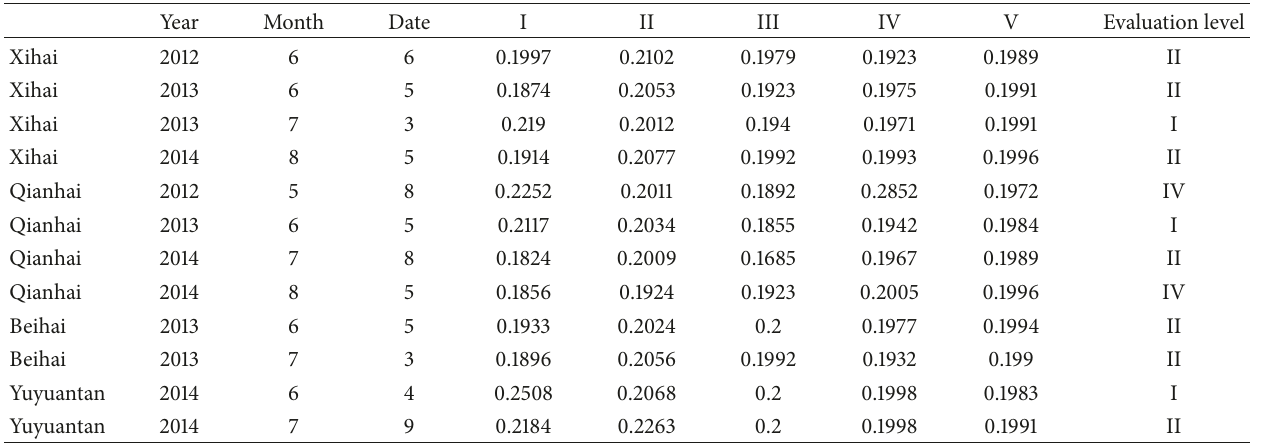
Table 8: Bayesian evaluation results for water